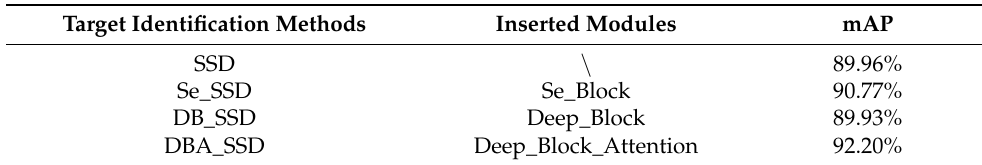
Table 2. Comparison of accuracy of improved SSD algorithm.